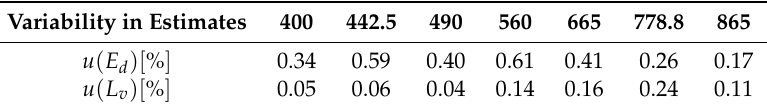
Table 6. Stability of E d and L w found by conducting 15 runs of the Monte Carlo Method with 10,000 draws. The values shown are the standard deviation of the standard uncertainty of E d and L w as a percentage of the mean of the standard deviations for each OLCI band.